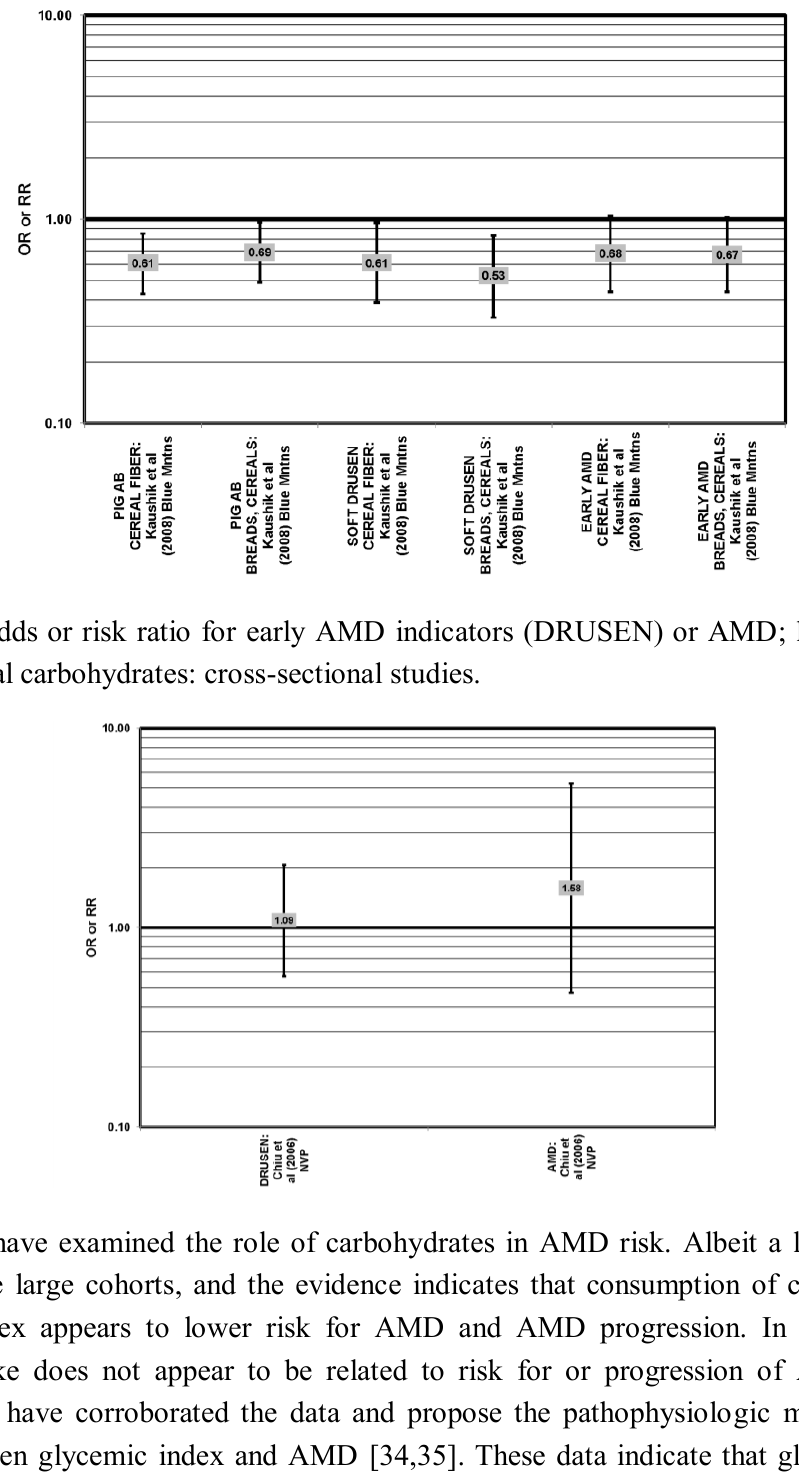
Figure 3. Odds ratio for early AMD indicators (PIG AB), late AMD indicators (SOFT DRUSEN), or early AMD; high vs. low intake of low glycemic index foods: prospective study.